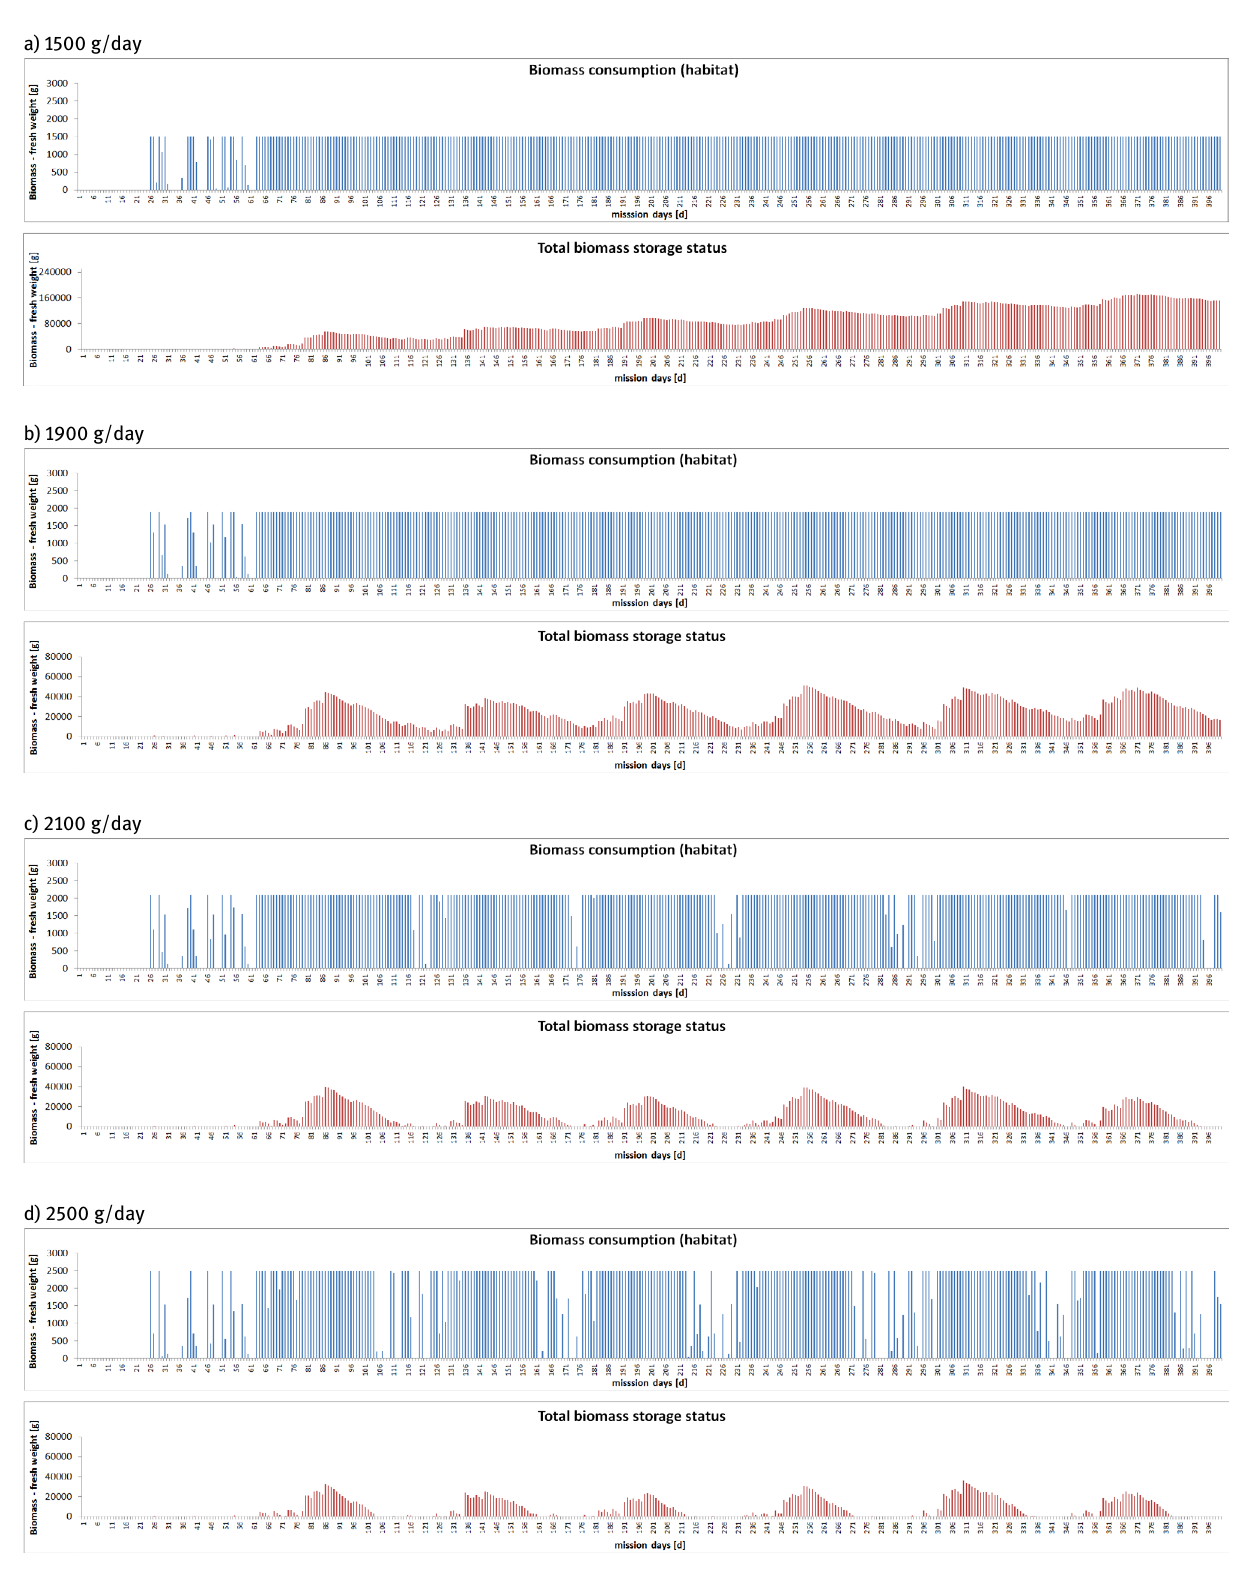
Figure 11: Different habitat biomass consumption set points versus total storage situation on a daily basis for IPC. The actual biomass consumption by the crew (10 crew members) are marked with the blue bars for each observation day. Five habitat demand set points were defined (1500 g/d to 3000 g/d), which represent the actual consumption by the crew. Partial blue bars represent the consumption of the crew that day, incorporating the remaining biomass of the storage system (red